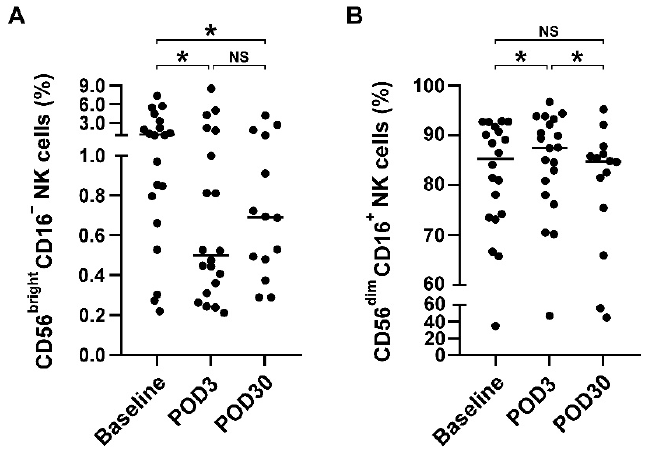
Figure 2. NK cell subsets were redistributed after cranial surgery. ( A ) Distribution of CD56 bright CD16 − NK subsets before and after surgery. Surface expression of CD56 and CD16 were classified by flow cytometric analysis. ( B ) Distribution of CD56 dim CD16 + NK subsets before and after surgery. Data were presented as scatter plot and median, and differences between groups were statistically analyzed using two-tailed Wilcoxon matched-pairs signed-rank test and. Differences were found to be statistically significant at * p < 0.05. NS indicates no statistically significant difference.